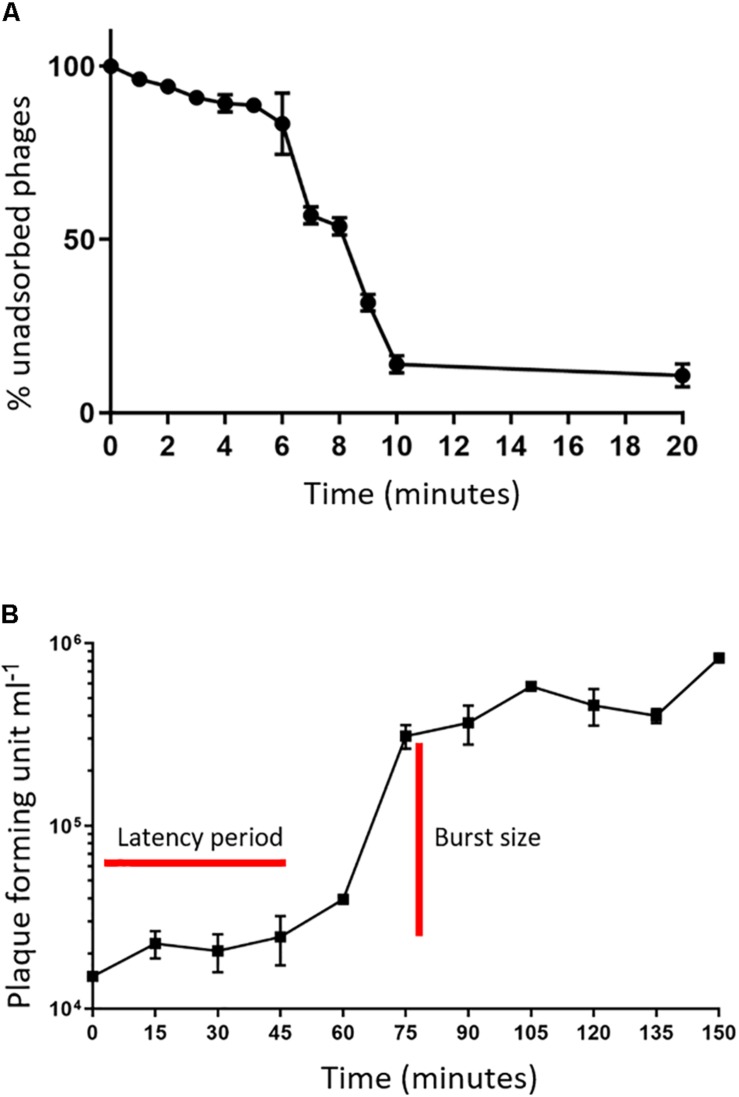
(A) Adsorption assay of phage MIJ3 on P. aeruginosa. (B) Growth parameters of MIJ3. The latent period of MIJ3 is between 45 and 50 min, and the burst size of one lytic cycle is 68 pfu per infected cell. Three biological replicates performed.